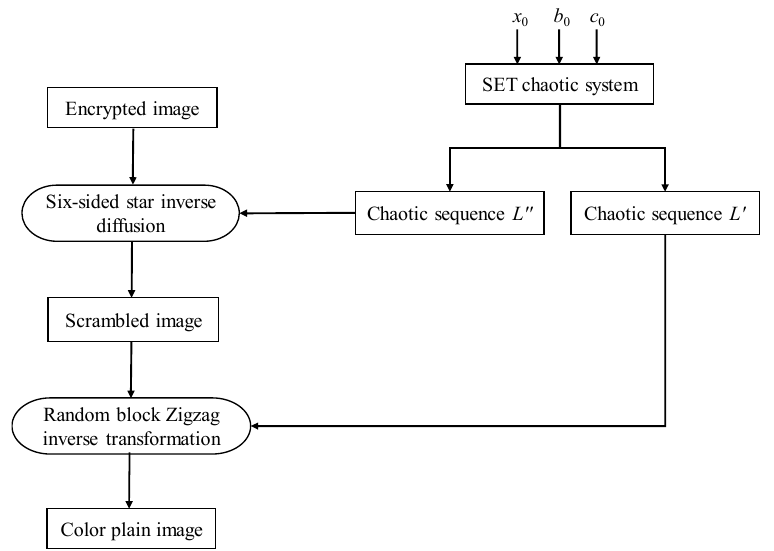
Figure 11. Flowchart of image decryption process.